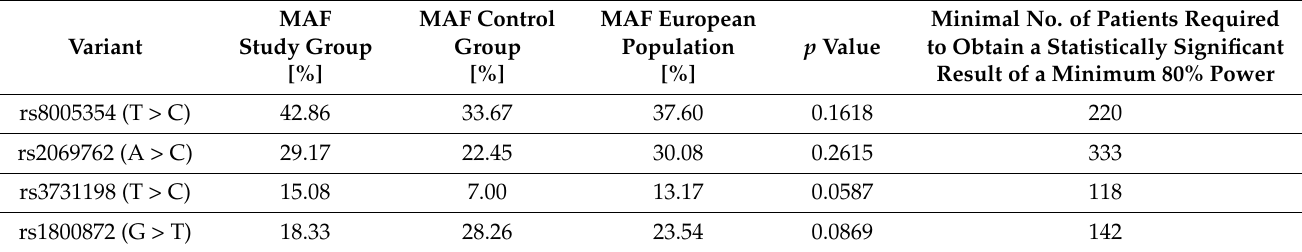
Table 2. Frequency of alleles in the study group, the control group, and the European population according to the Genome Aggregation Database (gnomAD) v2.1.1 for the European (non-Finnish) population.